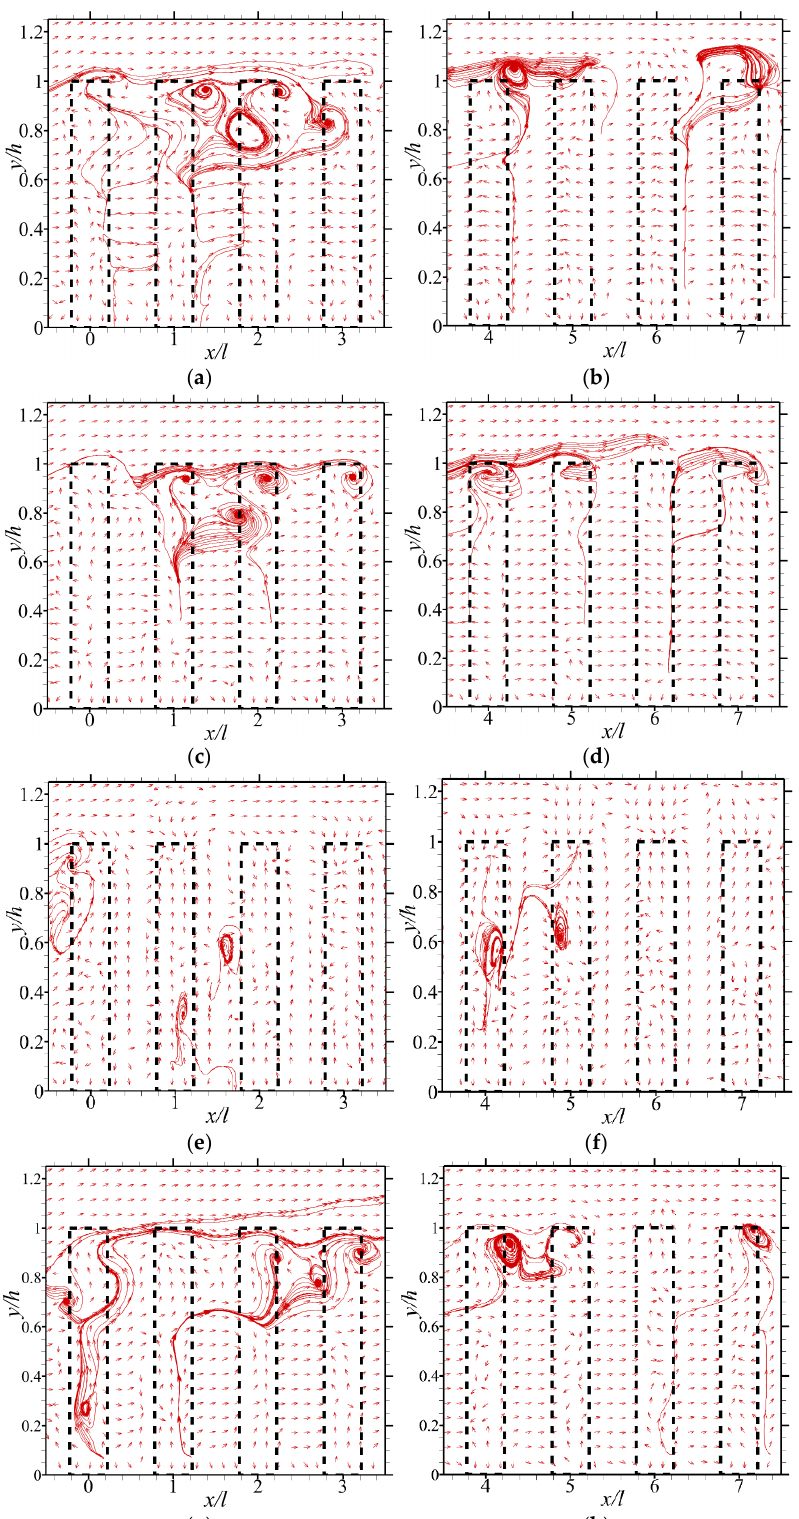
Figure 5. Vector plots with streamlines superimposed for selected rods at ( a , b ) z = l /2 in Test A ; ( c , d ) z = l /2 in Test B ; ( e , f ) z = − l/2 in Test A ; ( g , h ) z = − l/2 in Test B . Note that for each plot, dashed lines indicate locations of porous medium rods. Vectors and streamlines have also been skipped in order to maintain clarity and to highlight